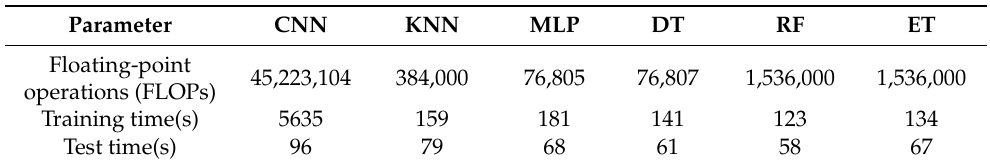
Table 7. Computational costs and complexities for the CNN, KNN, MLP, DT, RF, and ET classifiers on the phase-only image